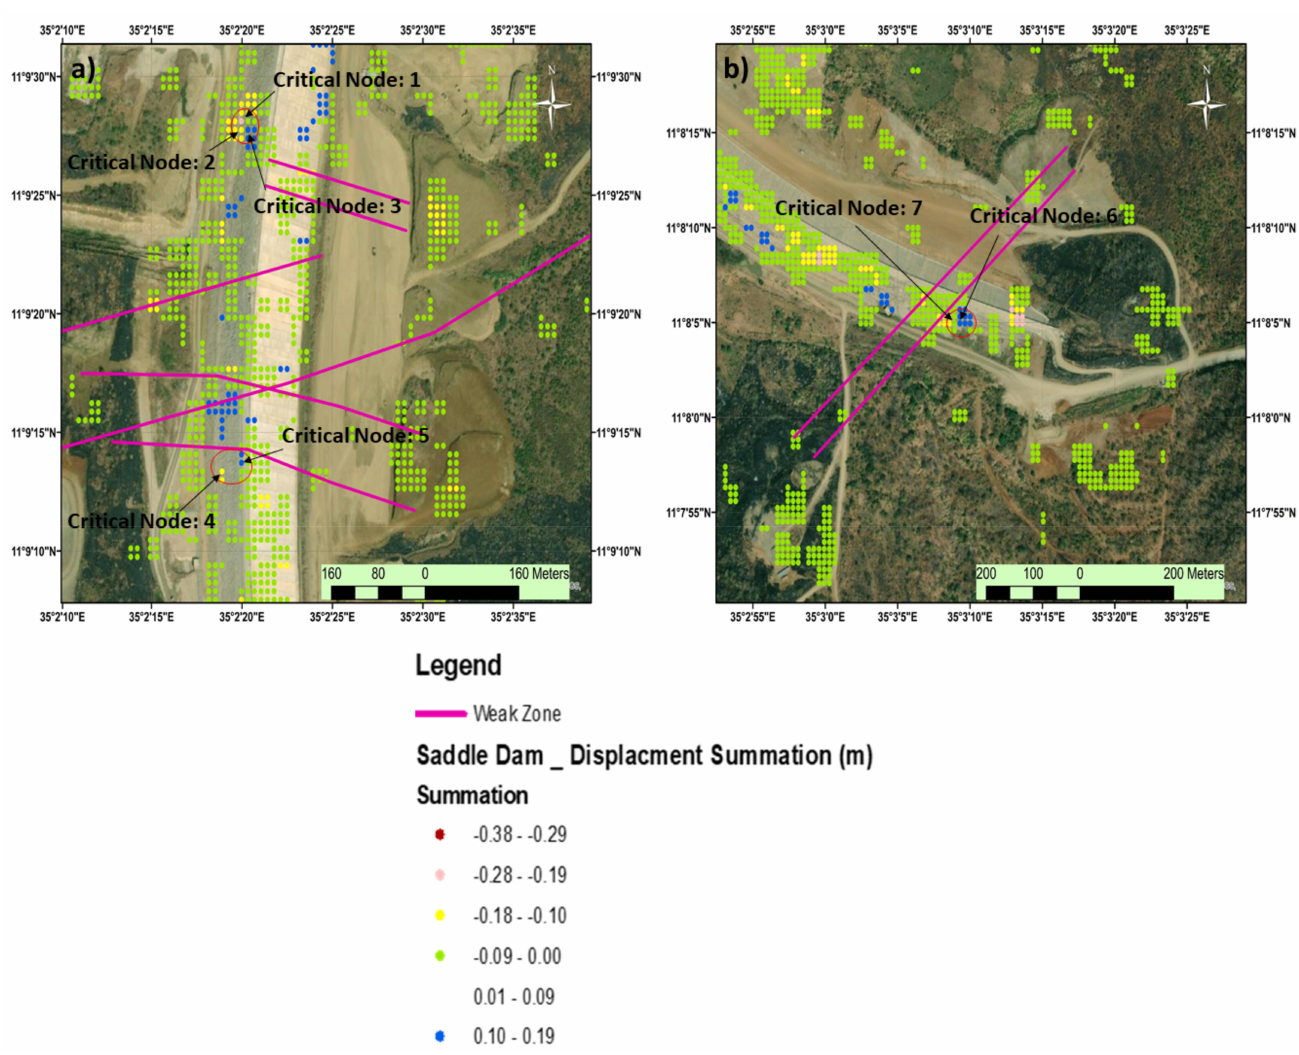
Figure 10. Vertical displacement observed over the seven critical nodes identified on the Saddle Dam showing ( a ) zoomed scene on critical nodes 1 to 5 and ( b ) focused scene on critical nodes 6 and